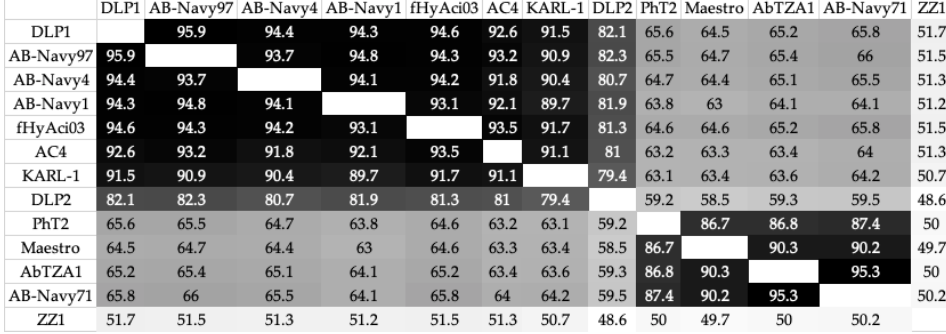
Figure 12. A rooted tree of the large terminase proteins of 11 published Acinetobacter T4-like phages. PHYML was used on a Clustal Omega alignment of the TerL protein, using Escherichia phage T4 to root the tree. Branch support is shown from 100 bootstrap replicates. Blue represents the Lazarusvi- rus clade, green represents the Hadassahvirus clade. Phage ZZ1 (red) forms the Zedzedvirus clade. Further comparison of the DLP1 and DLP2 genomes with MAFFT against the T4-like